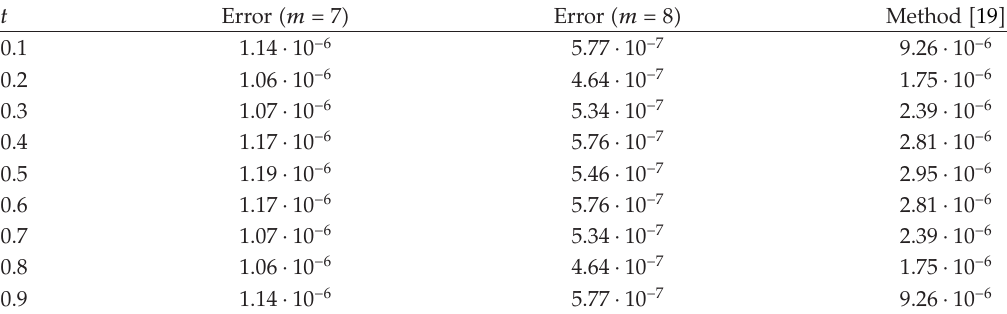
Table 9: Problem (cid:4) 5.10 (cid:5) —Example 5.8, λ (cid:6)